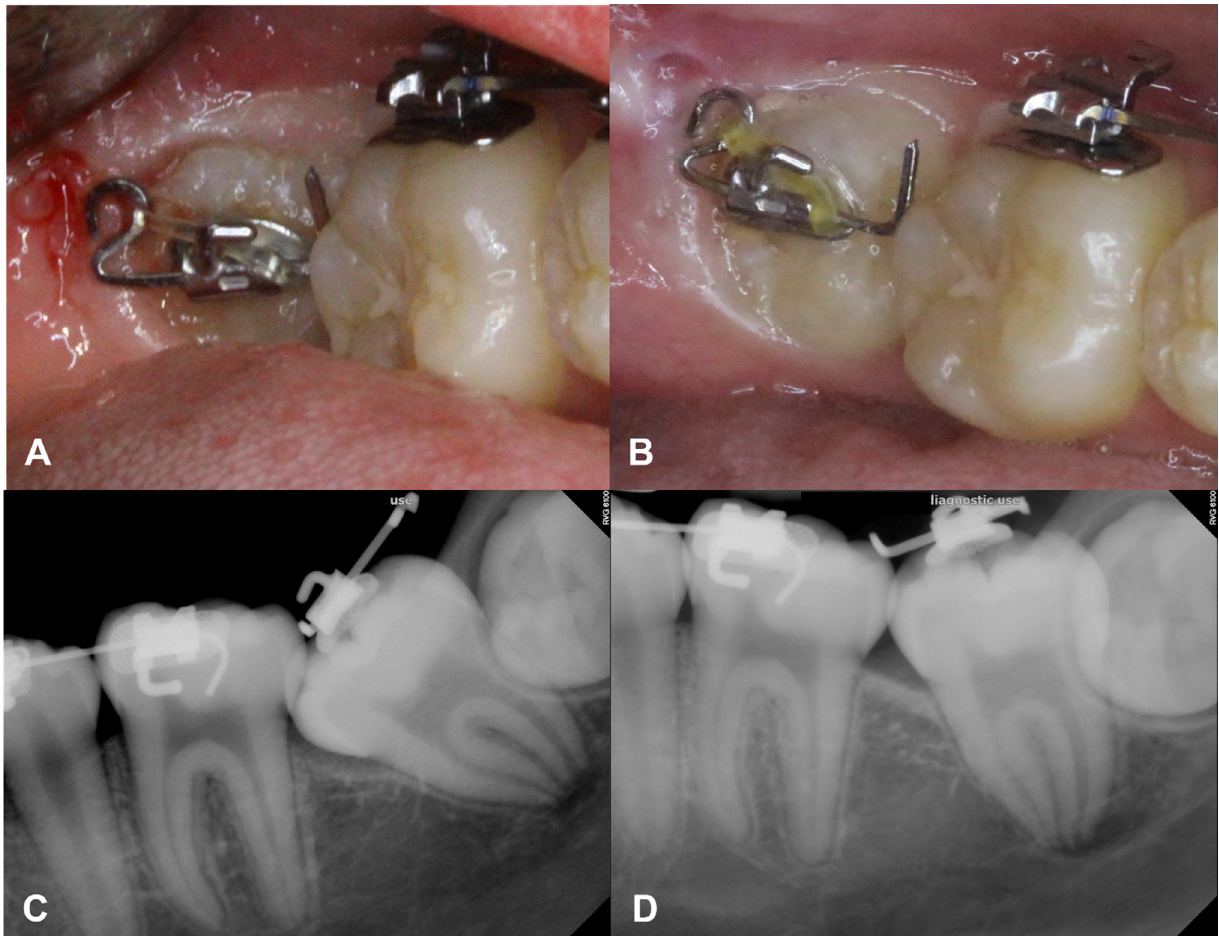
Figure 4. Piston-elastic during the orthodontic treatment. ( A , C ) Mesially angulated ectopic impaction of the right second molar was found during orthodontic treatment in a 13-year-old healthy girl. ( B ) As it showed the limited buccal surface for the bracket attachment, a piston-elastic device was attached on the exposed occlusal surface. ( D ) After 2 months of the attachment, a definite change in the eruption path was observed .